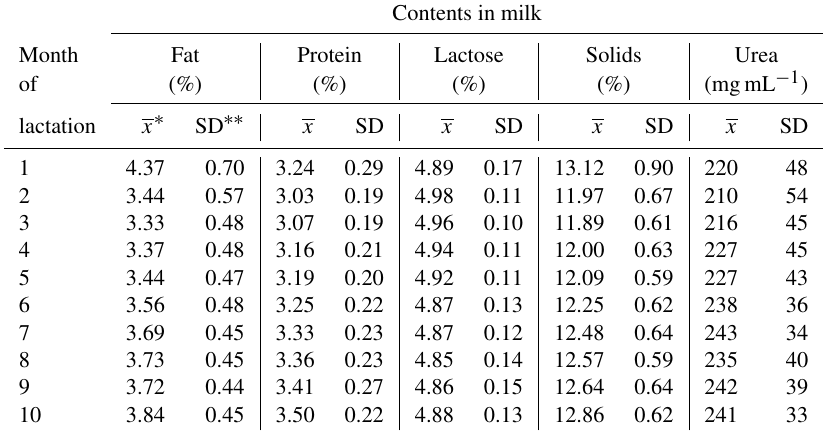
Table 2. Changes in chemical composition in milk of primiparous cows in the course of lactation. Contents in milk Month Fat Protein Lactose Solids Urea of (%) (%) (%) (%) (mgmL − 1 ) lactation x ∗ SD ∗∗ x SD x SD